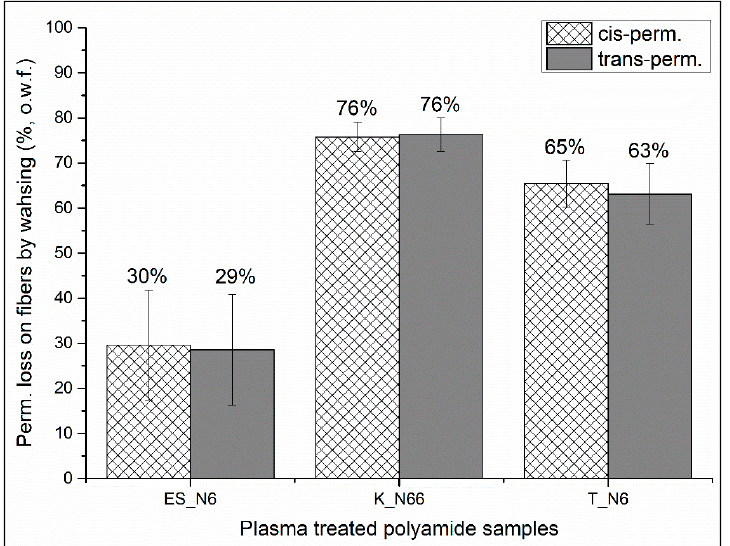
Figure 9. Weight loss of permethrin on plasma-treated polyamide fabrics after washing.